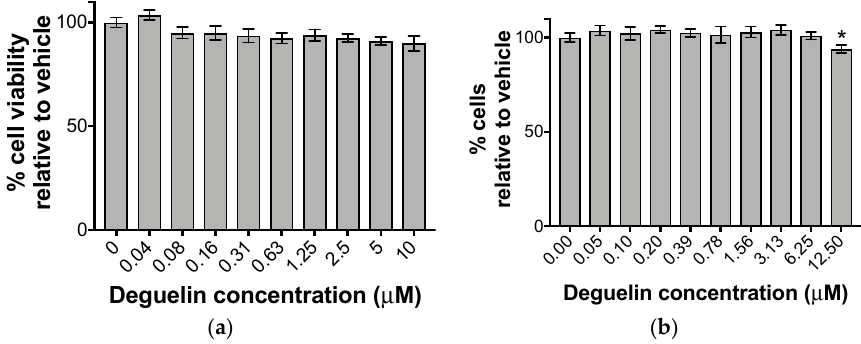
Figure 3. Deguelin treatment was not cytotoxic or cytostatic to fibroblasts. ( a ) NuFF-1 cells were grown to confluence and then treated with vehicle (DMSO) or increasing concentrations of deguelin, as indicated, for 72 h. Cell viability was then assessed by 3-(4,5-dimethylthiazol-2-yl)-2,5-diphenyltetrazolium bromide (MTT) assay. Data was recorded at 570 nm using a Cytation 3 plate reader. Data is presented as percent (%) inhibition relative to vehicle. ( b ) NuFF-1 cells were plated at 25% confluence and then treated with vehicle (DMSO) or increasing concentrations of deguelin. Cells were allowed to undergo two cell doublings, and were then assayed using the method used in ( a ). Data is presented as the number of cells relative to vehicle. Error bars represent the standard deviation of three technical replicates. Replicate assays were performed ( n = 3), and a representative biological replicate is shown in each panel. Statistical analyses were performed using Student’s t -test between each indicated concentration relative to the vehicle-treated cells; * p < 0.01.